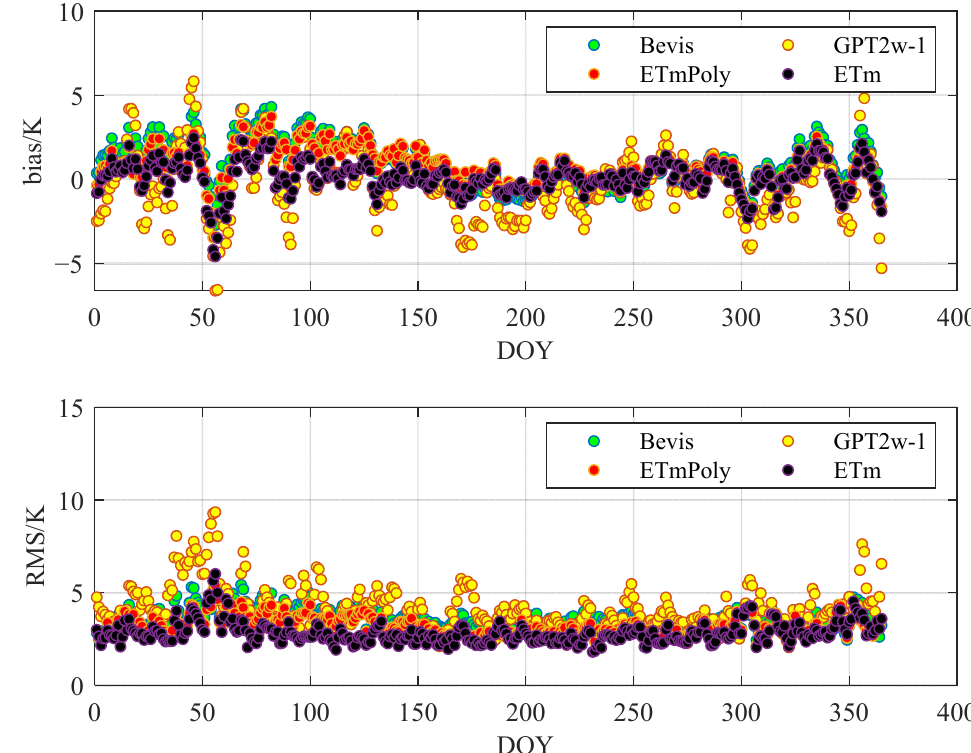
Figure 6. Results of the four Tm models validated using 48 modeling radiosonde data during different days of the year 2021.